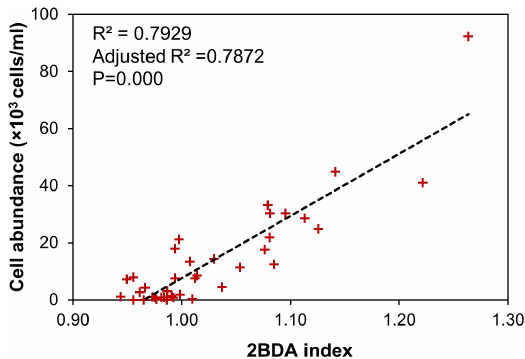
Figure B1. Scatterplot of measured cell abundance vs. 2BDA index listed in Table B1.